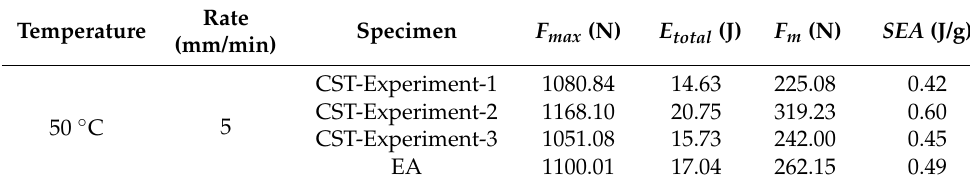
Table 8. Experimental results of CST at 50 ◦ C.